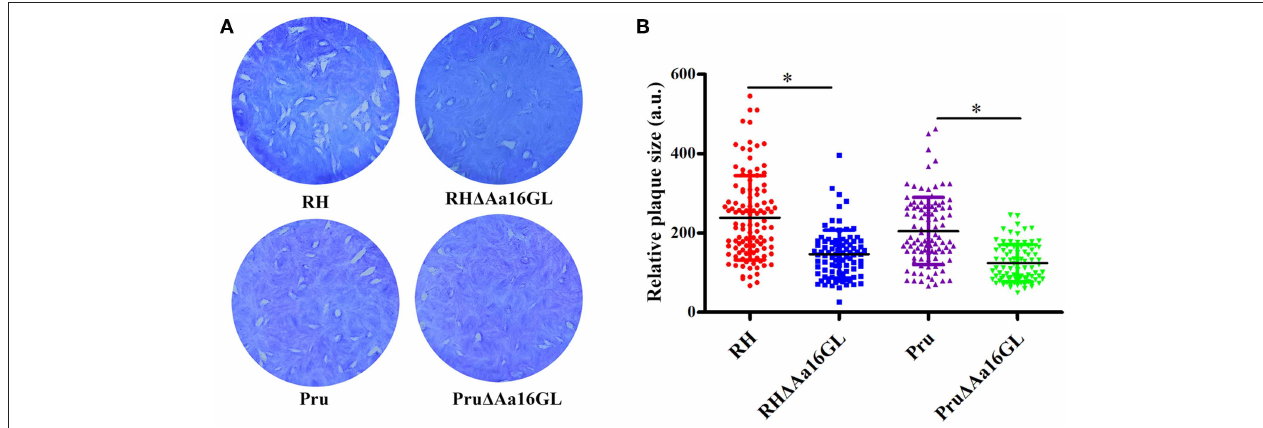
FIGURE 3 | Plaque assay comparing the growth of amylo-alpha-1,6-glucosidase mutant to that of their parental strain. (A) Plaque assay of the Aa16GL mutants and their parental strains. (B) The sizes of plaques generated by Aa16GL mutants were significant smaller than that generated by their parental strains (* P < 0.05). Differences were significant in all three experiments analyzed by Student’s t